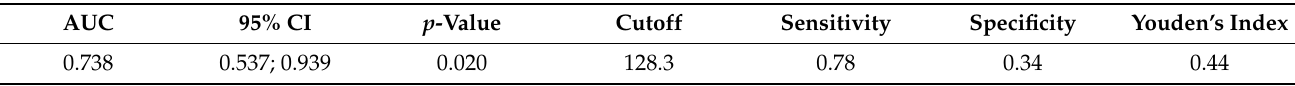
Table 6. Area under the curve (AUC) value and cutoff for Zn/Cu ratio for prediction normal